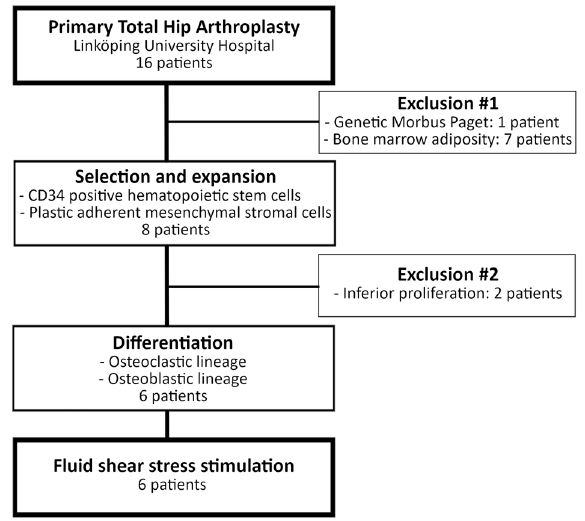
Figure 1. Flowchart showing the selection of samples. From the 16 patients undergoing primary total hip arthroplasty, ten patients had to be excluded from this study as they exhibited genetic Morbus Paget’s disease, predominantly adipose bone marrow, or insufficient proliferation of their isolated stem cells.